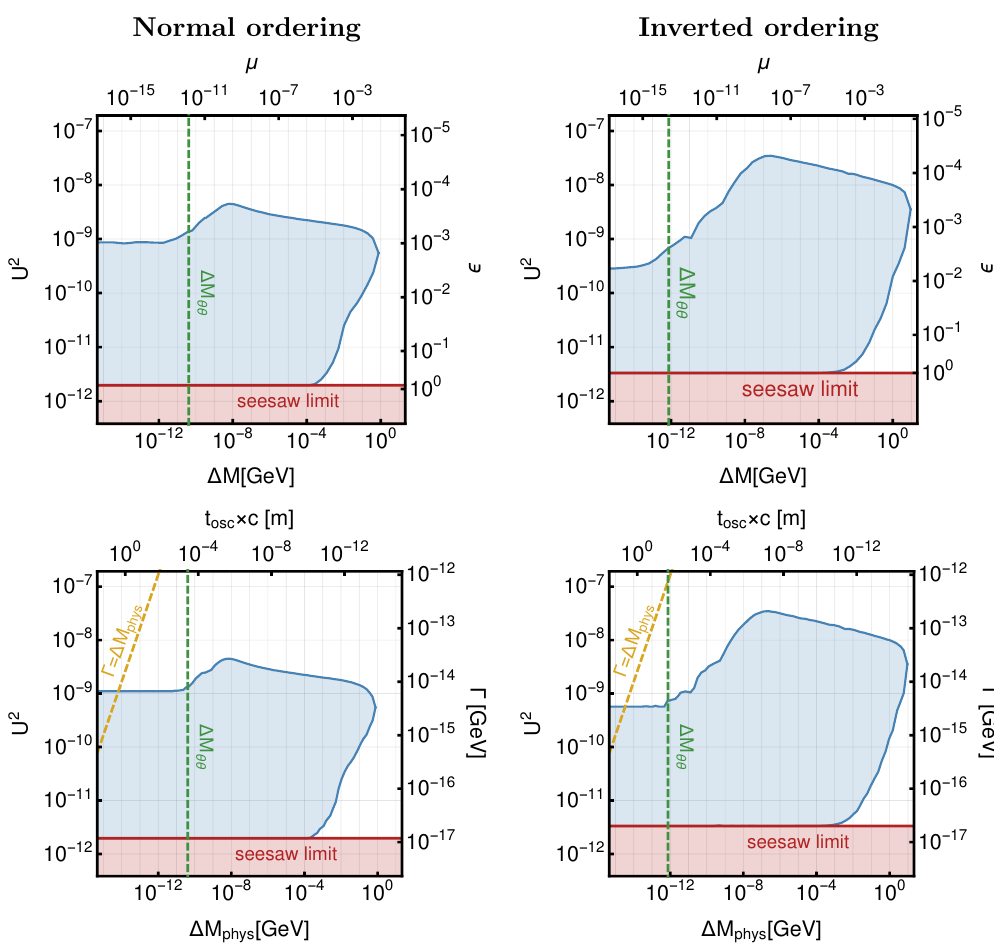
Figure 10 . The allowed mixings U 2 in comparison to the Lagrangian mass splittings (cid:1) M (upper panels) and the physical mass splittings (cid:1) M phys (lower panels) with an average mass (cid:22) M = 30 GeV are shown in blue for normal ordering (left panels) and inverted ordering (right panels), respectively. The red line represents the seesaw limit, below which the parameter region is excluded by neutrino oscillation data. The vertical, dashed, green lines correspond to the di(cid:11)erence (cid:1) M (cid:18)(cid:18) between the eigenvalues of M N , cf. eq. (2.11), solely from the coupling to the Higgs (cid:12)eld. The physical mass splitting (cid:1) M phys acessible in experiments is related to the mass splitting (cid:1) M in the electroweak unbroken phase and (cid:1) M (cid:18)(cid:18) by eq. (2.15). Note that leptogenesis is possible even for (cid:1) M = 0 due to (cid:1) M (cid:18)(cid:18) 6 = 0 during the electroweak